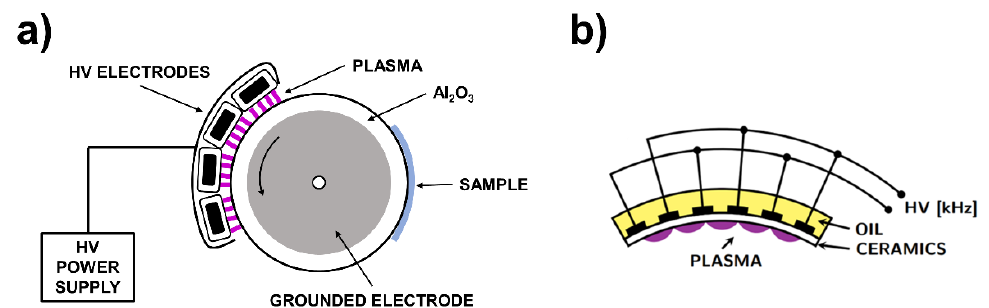
Figure 1. Schematic representation of used plasma sources: ( a ) VDBD electrode system and ( b ) concavely curved DCSBD electrode system.